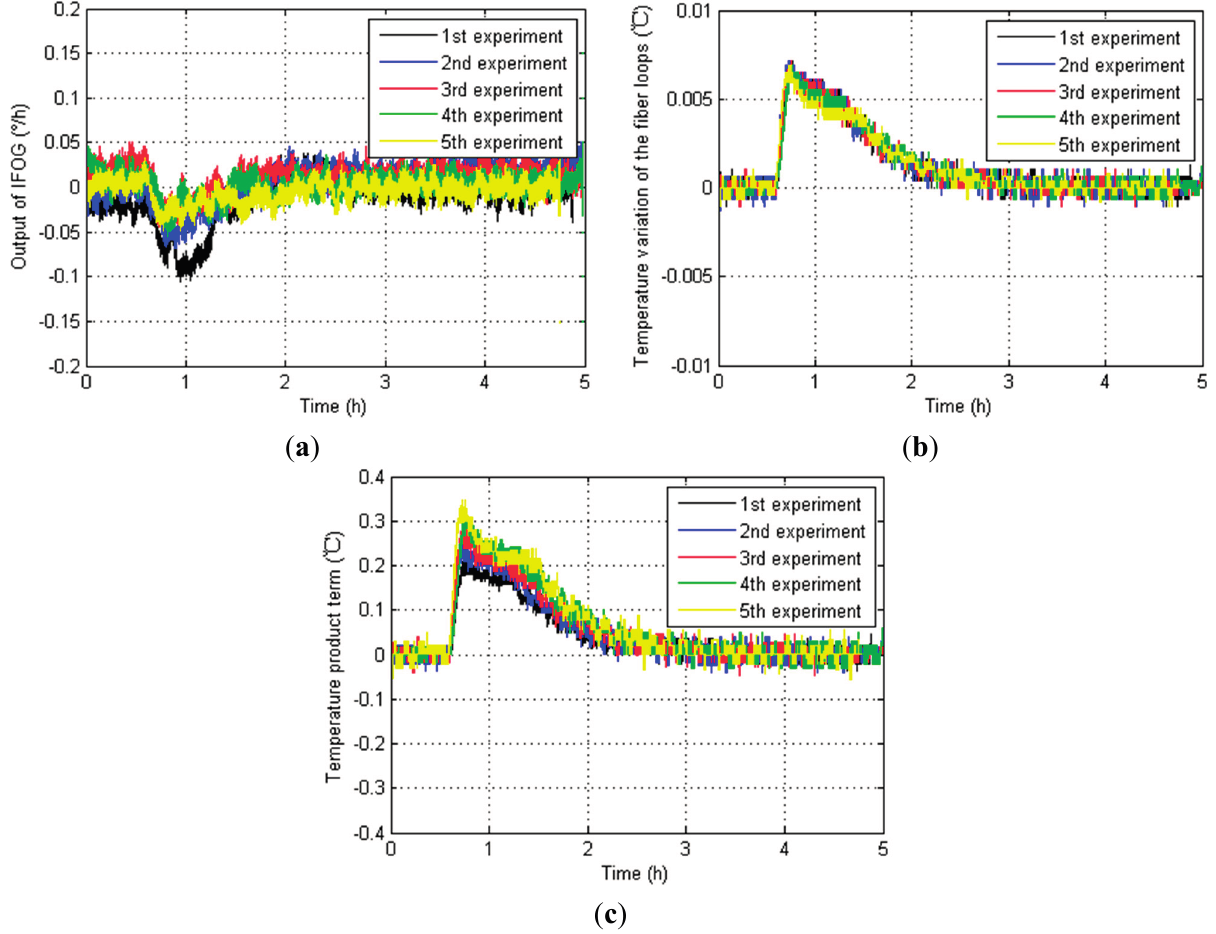
Figure 7. Relevant test results from NO.1 IFOG. ( a ) IFOG outputs; ( b ) Fiber loop temperature variation ∆ T ; ( c ) Temperature product term T × ∆ T